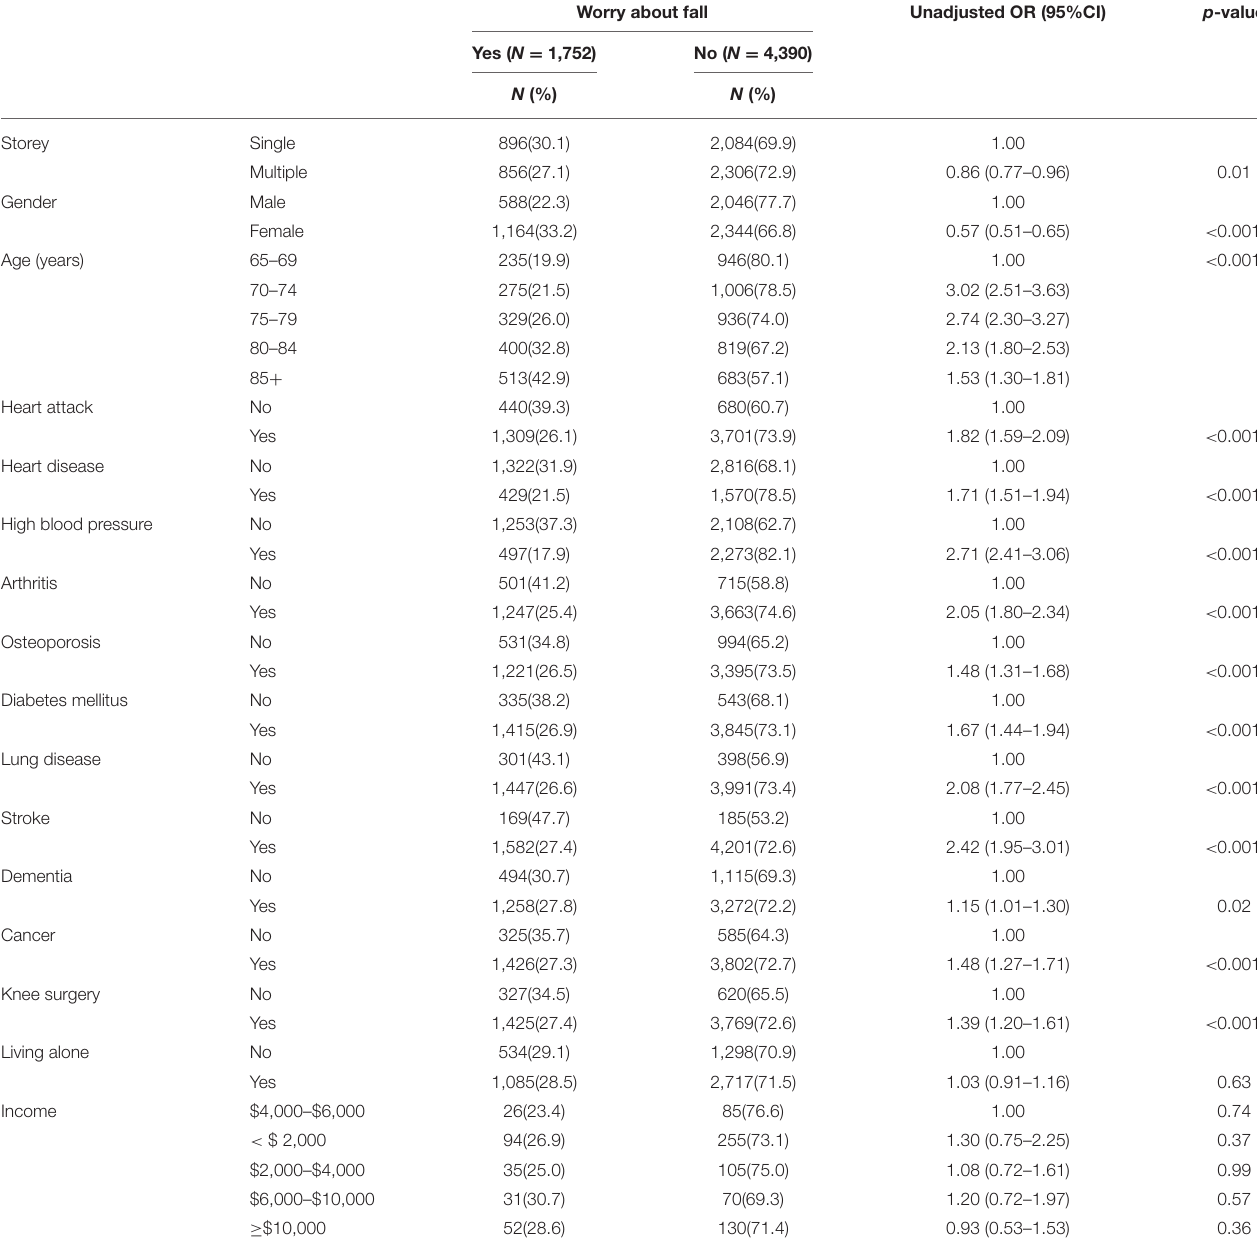
TABLE 2 | Univariate analysis on the factors associated with worry about fall ( n = 6,142). Worry about fall Unadjusted OR (95%CI) p -value